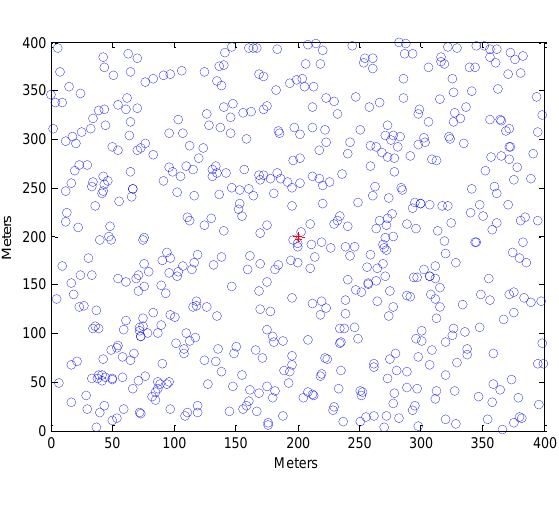
Figure 4. Nodes distribution.